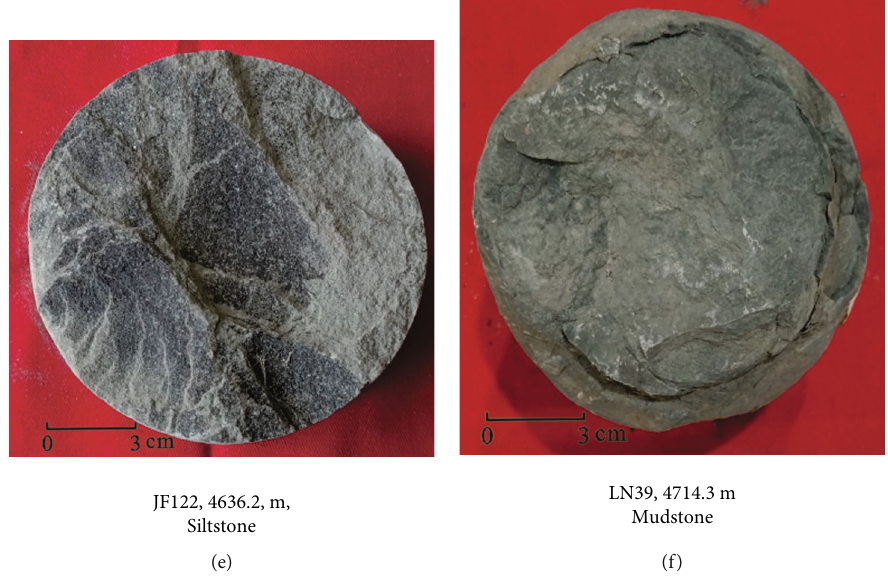
Figure 2: Typical lithology photos from TIII1 sand group in Sangtamu Oil fi